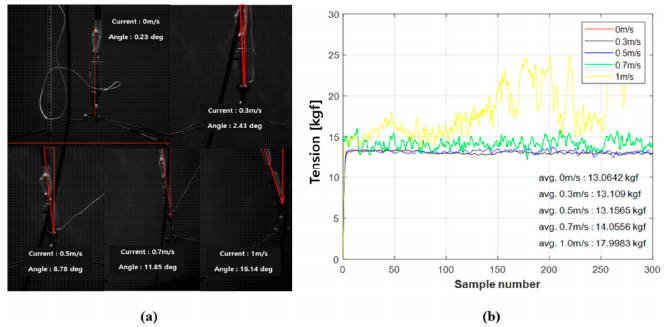
Figure 10. Scheme of water tank test for measuring force.